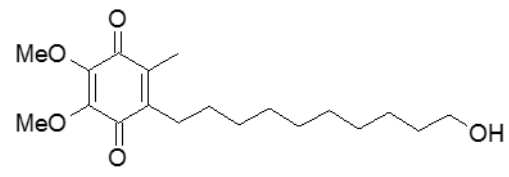
Figure 5. Chemical structure of idebenone.